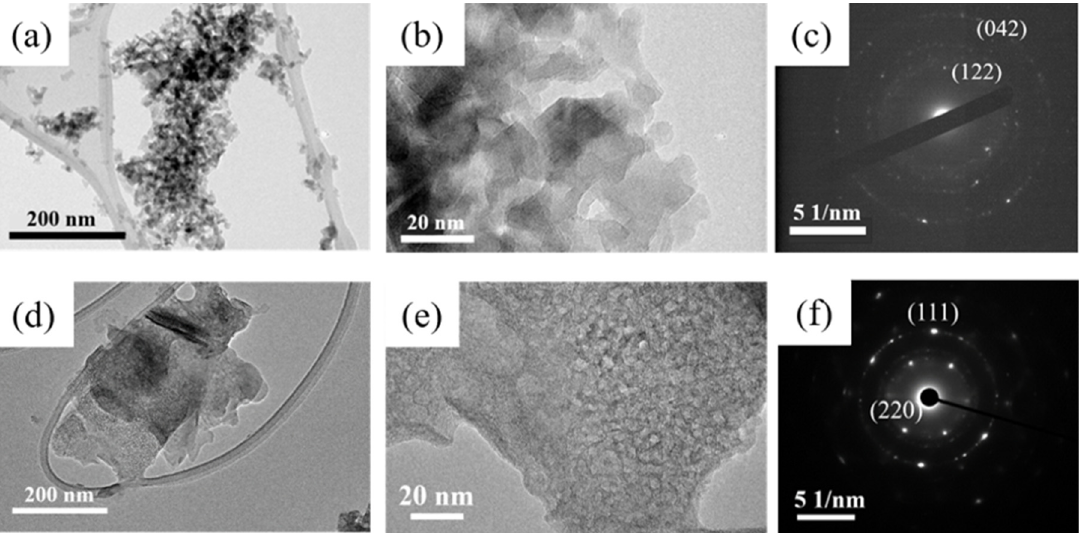
Figure 2. ( a , b ) TEM images of the as-prepared δ − Al 2 O 3 . ( c ) SAED pattern of δ − Al 2 O 3 . ( d , e ) TEM images of the as − prepared MnO. ( f ) SAED pattern of MnO.